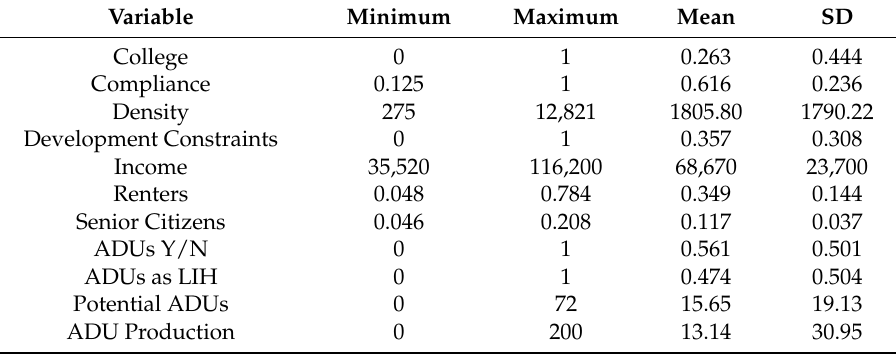
Table 3. Descriptive statistics of the inferential data. Notes: ADU = accessory dwelling unit, LIH = low-income housing, SD = standard deviation, Y/N = yes or